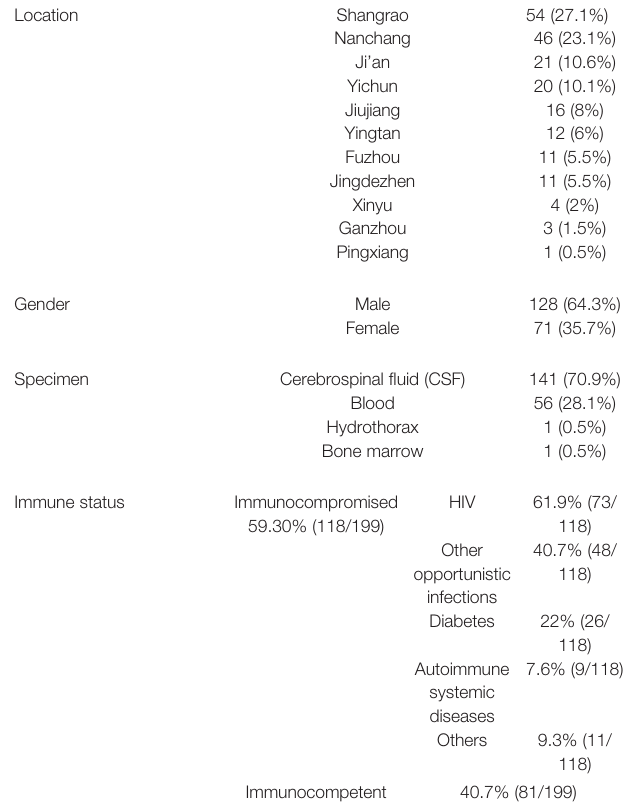
TABLE 1 | Clinical information of 199 cryptococcus neoformans